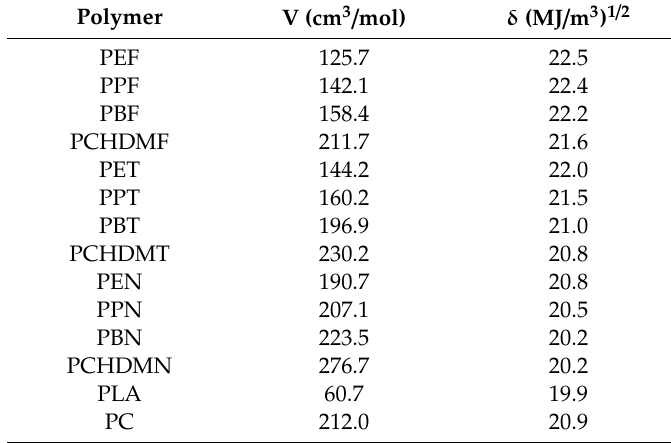
Table 1. Molar volumes, V, and solubility parameter values, δ , for the polymers studied in this work and used in